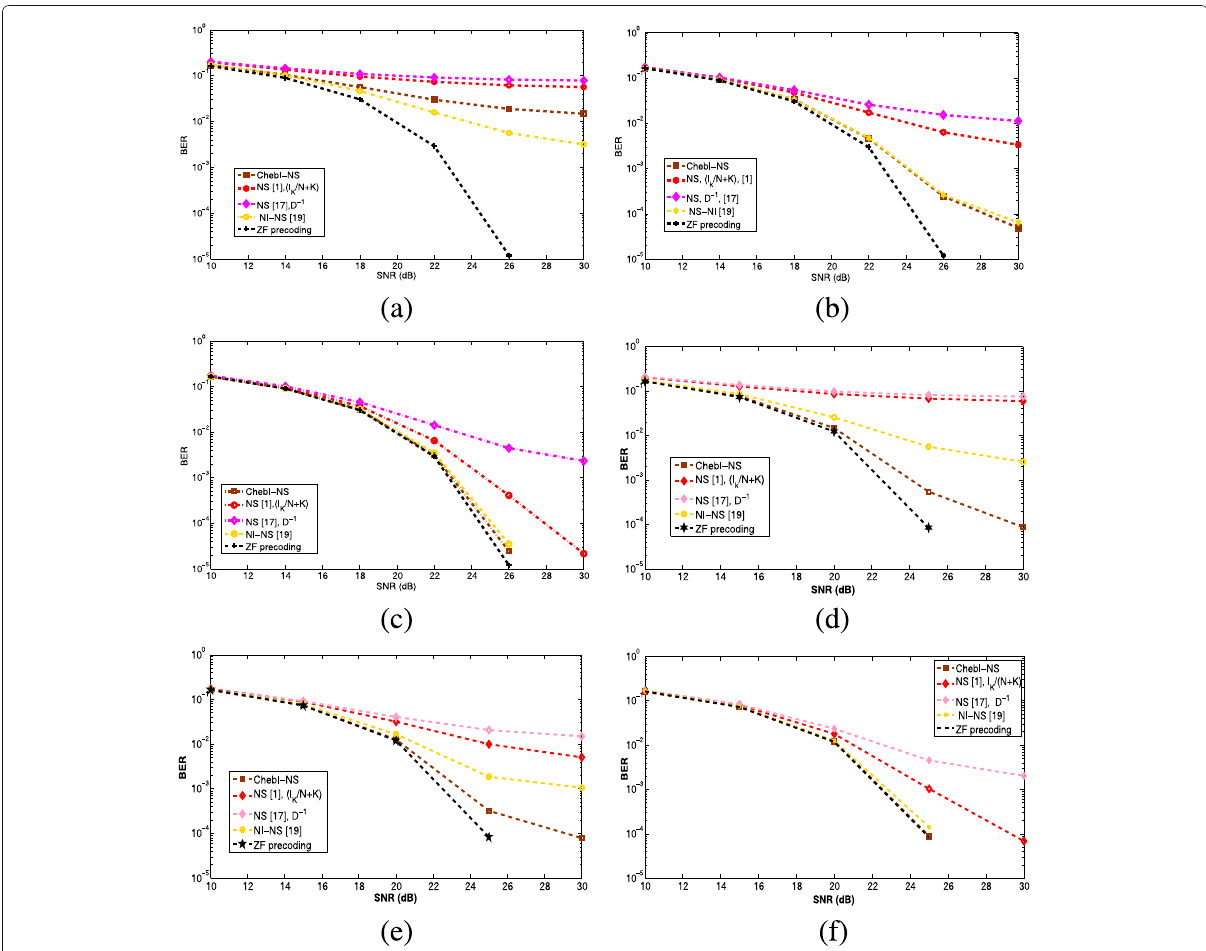
Fig. 3 BER performance comparison between different joint NS methods with ChebI-NS method in mMIMO system with N = 128 and K = 16 under uncorrelated and correlated channel, respectively. This figure compares ChebI-NS with other previous NS methods for iterations i = 2, 3, 4 under both correlated and uncorrelated channel conditions. a Uncorrelated channel, i = 2. b Uncorrelated channel, i = 3. c Uncorrelated channel, i = 4. d Correlated channel, i = 2. e Correlated channel, i = 3. f Correlated channel, i =